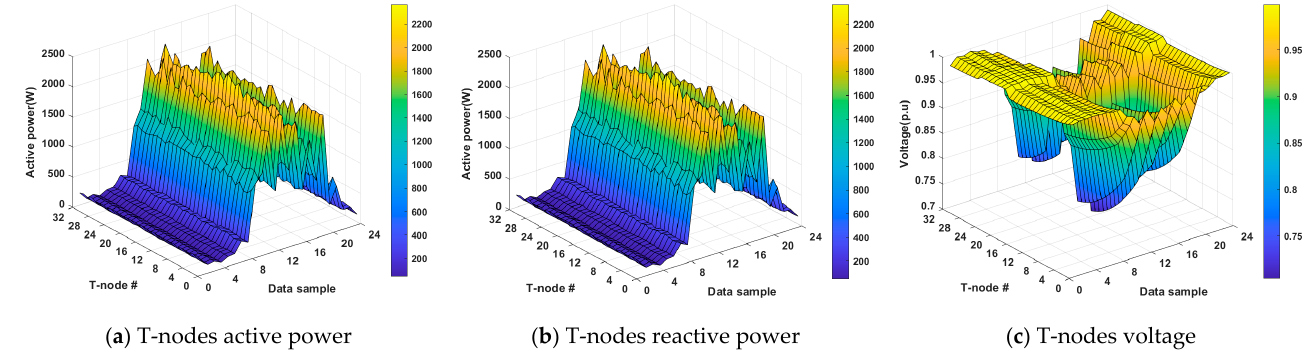
Figure 11. T-nodes Load profile.